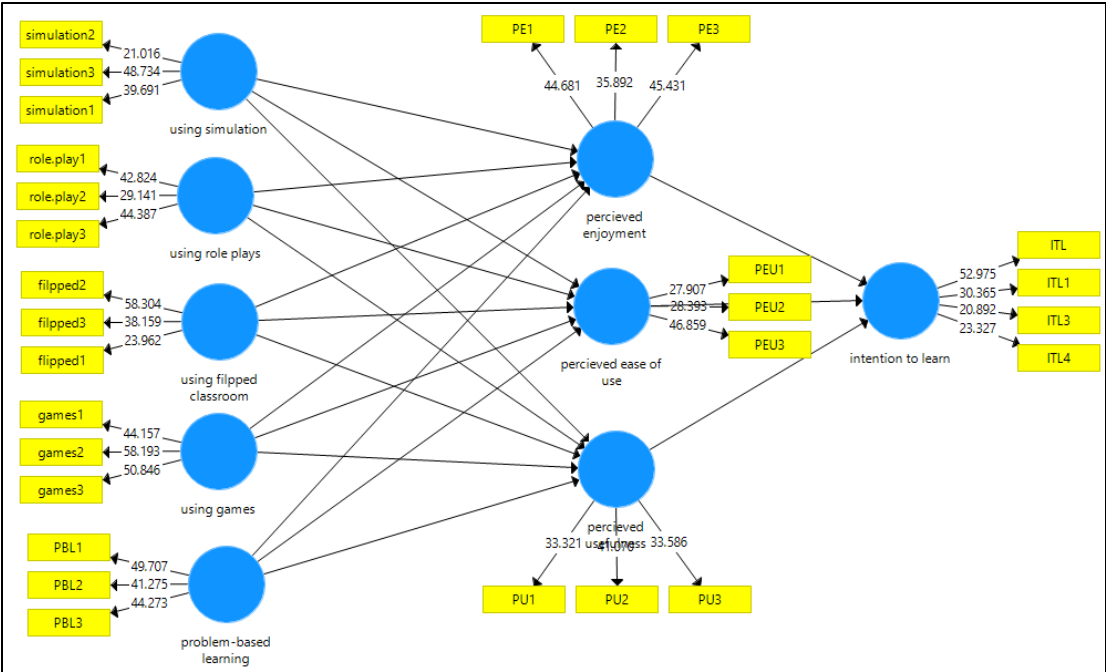
Fig. 2. Structural Research